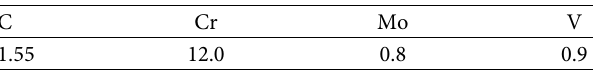
Figure 1: Electrical discharge processing machine used in the experimental study. Table 1: Chemical composition (%) of the AISI D2 (raw material) cold work tool steel used in the study.